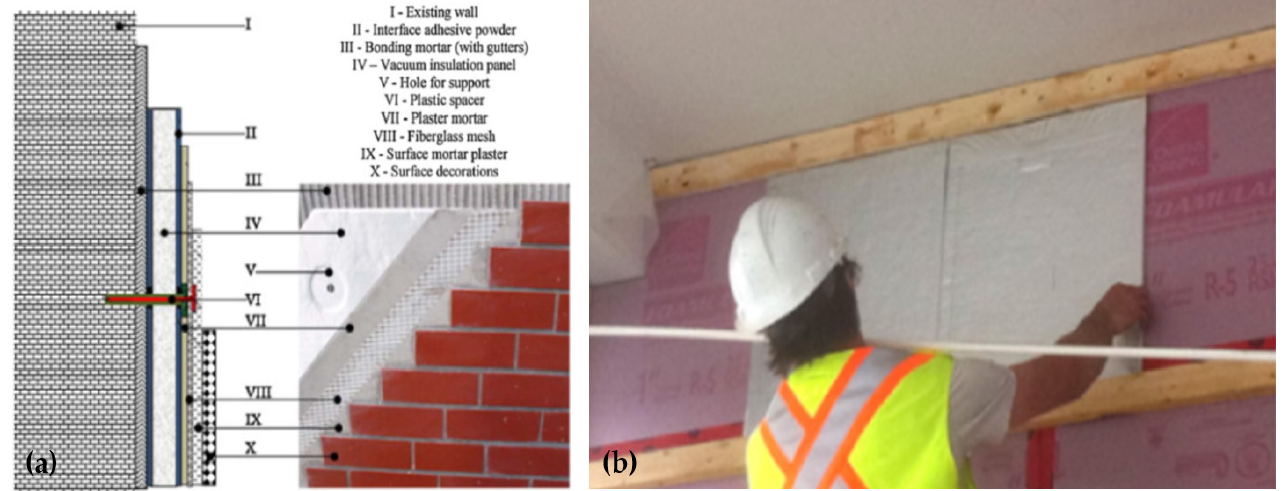
Figure 8. ( a ) Assembly of a vacuum insulation system, and ( b ) commercial vacuum insulation pan- els